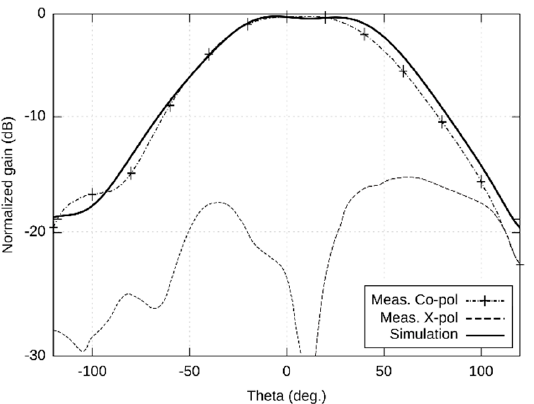
Figure 3. Simulated and measured radiation patterns (XZ plane) of the antenna designed for the 5.8 GHz ISM band.